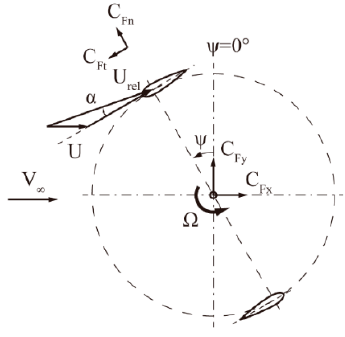
Figure 2. Sign convention of the variables.